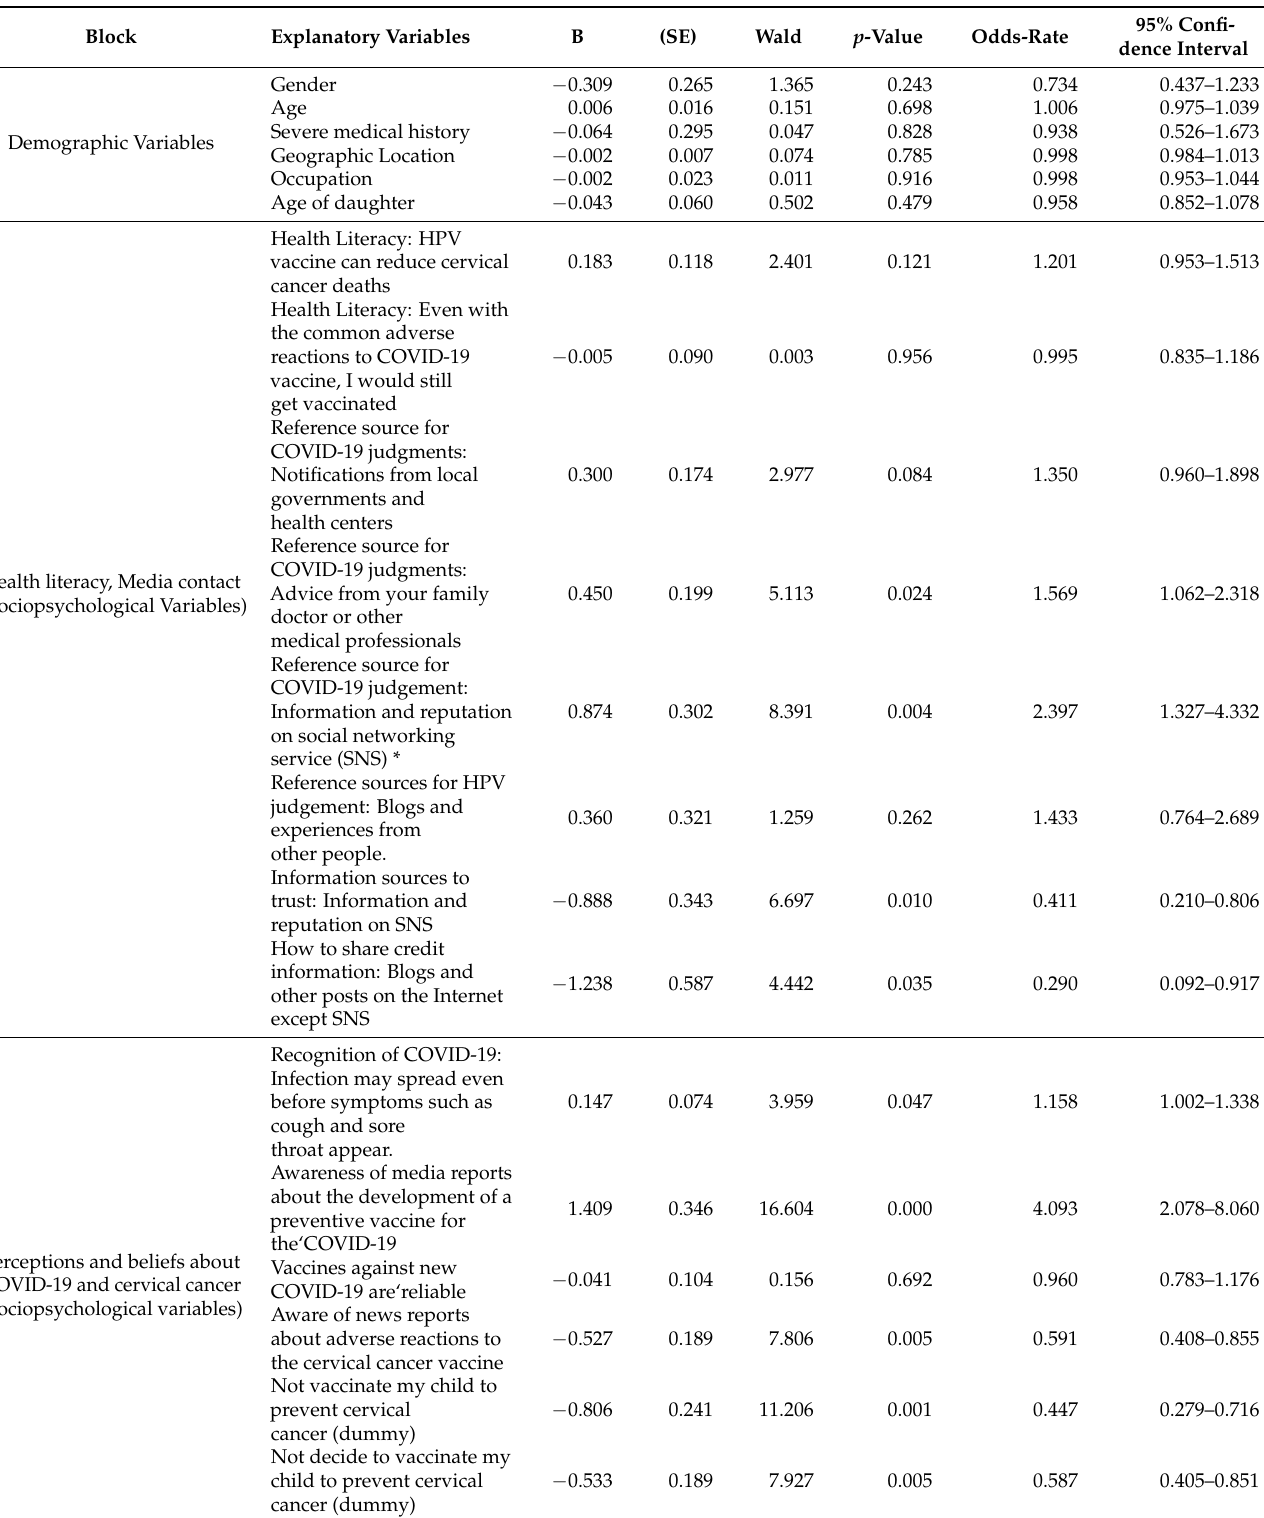
Table 5. Logistic regression analysis of common adverse reactions to HPV vaccination